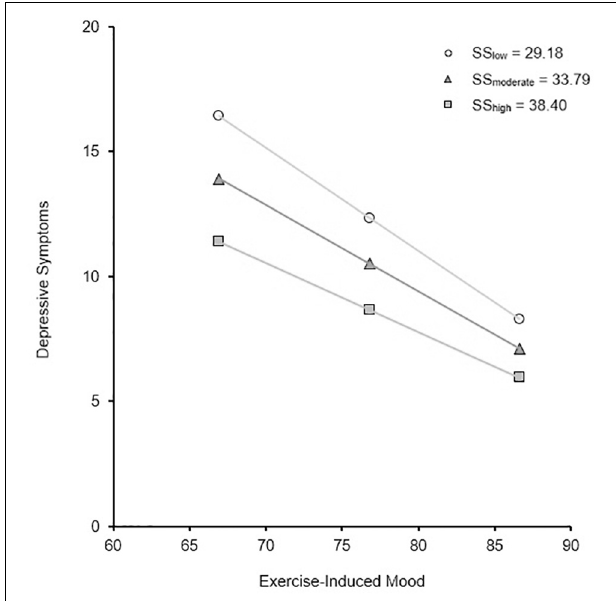
FIGURE 1 | Simple slopes of the relationship between depressive symptoms and exercise-induced mood for low ( M – 1 SD ), moderate ( M ), and high ( M + 1 SD ) levels of social support in community-dwelling older adults aged 65–96 years ( n =